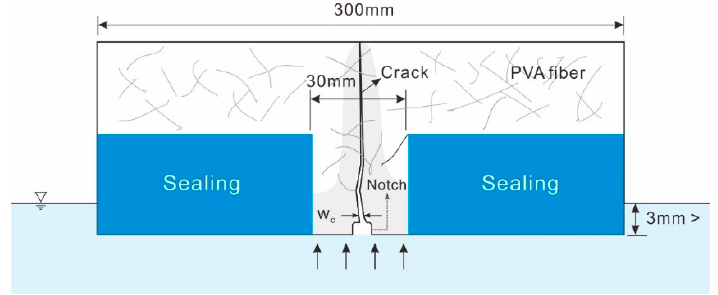
Figure 3. Diagram of water absorption test.